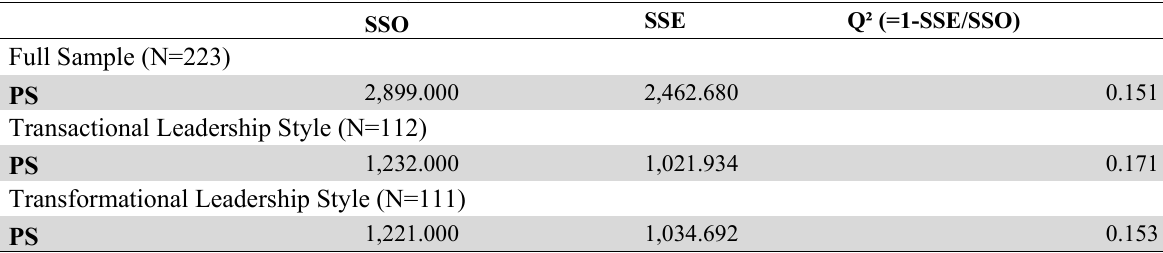
Construct Crossvalidated redundancy